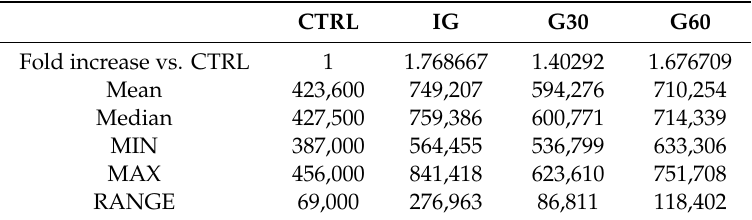
Table 1. Epithelium thickness has been measured with ImageJ software and is expressed in pixels. Values have been normalized on CTRL (unexposed) group and thickness is expressed as fold increase versus CTRL. Descriptive statistic parameters are shown. CTRL IG